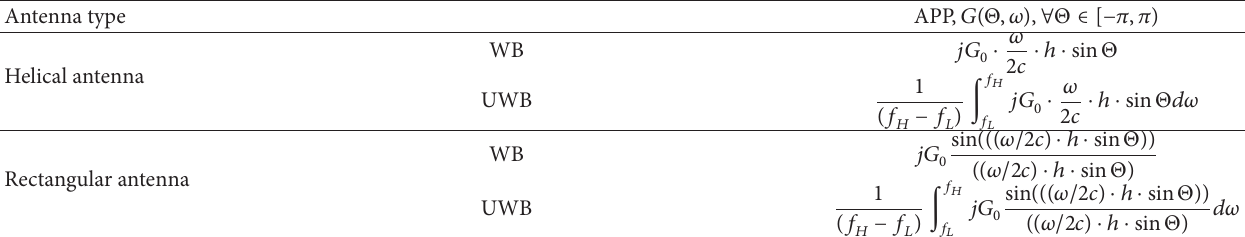
Table 1: 2D antenna radiation patterns.